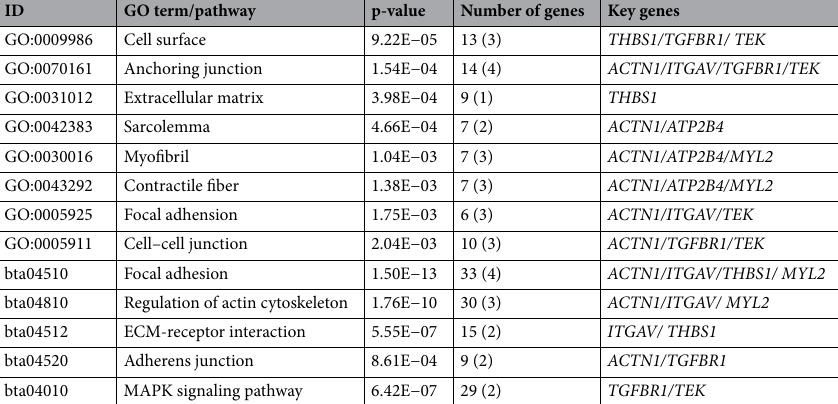
Table 4. Most important GO terms and pathways of DEGs between H-WHC and L-WHC groups. GO gene ontology, KEGG Kyoto Encyclopedia of Genes and Genomes, DEGs differently expressed genes, MAPK mitogen-activated protein kinase, ECM extracellular matrix. Number of genes: the first number represents the total number of genes enriched per GO term or pathway; the second number represents the number of key genes displayed in the next column. Combined with the biological function analysis of genes and the previous relevant studies on the regulatory mechanism of WHC, the DEGs involved in more than three GO terms and three pathways could be identified as key genes that are listed in the fifth column of the